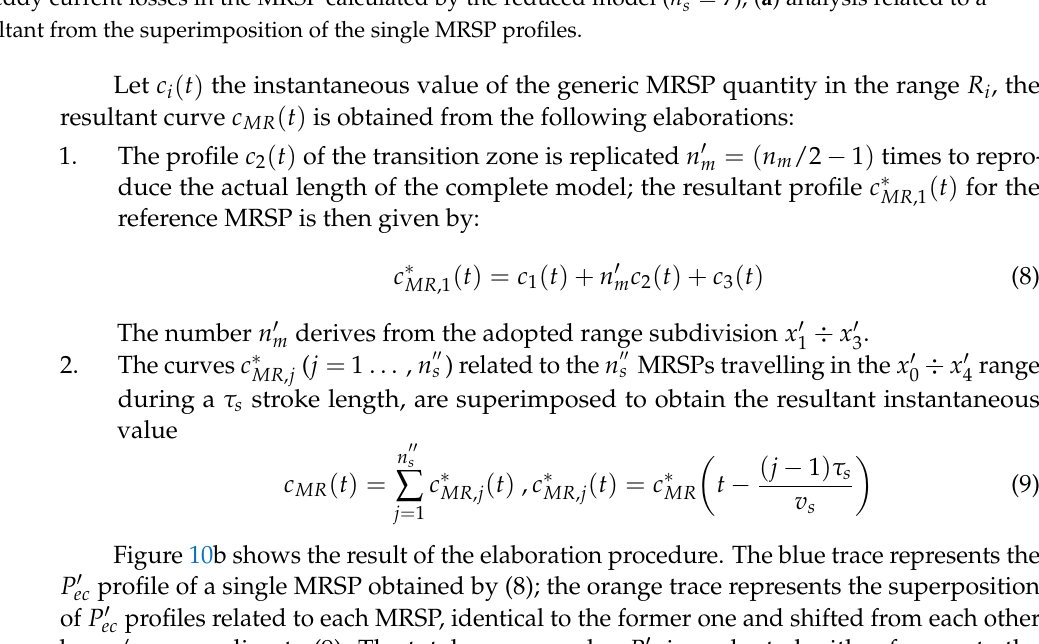
Figure 10. Pu depth eddy current losses in the MRSP calculated by the reduced model ( 𝑛 𝑠′ = 7); ( a ) analysis related to a single MRSP; ( b ) resultant from the superimposition of the single MRSP profiles.